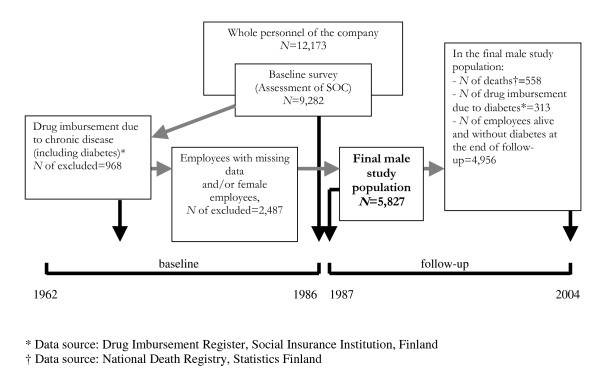
Study design, sample selection, and description of the final study population.